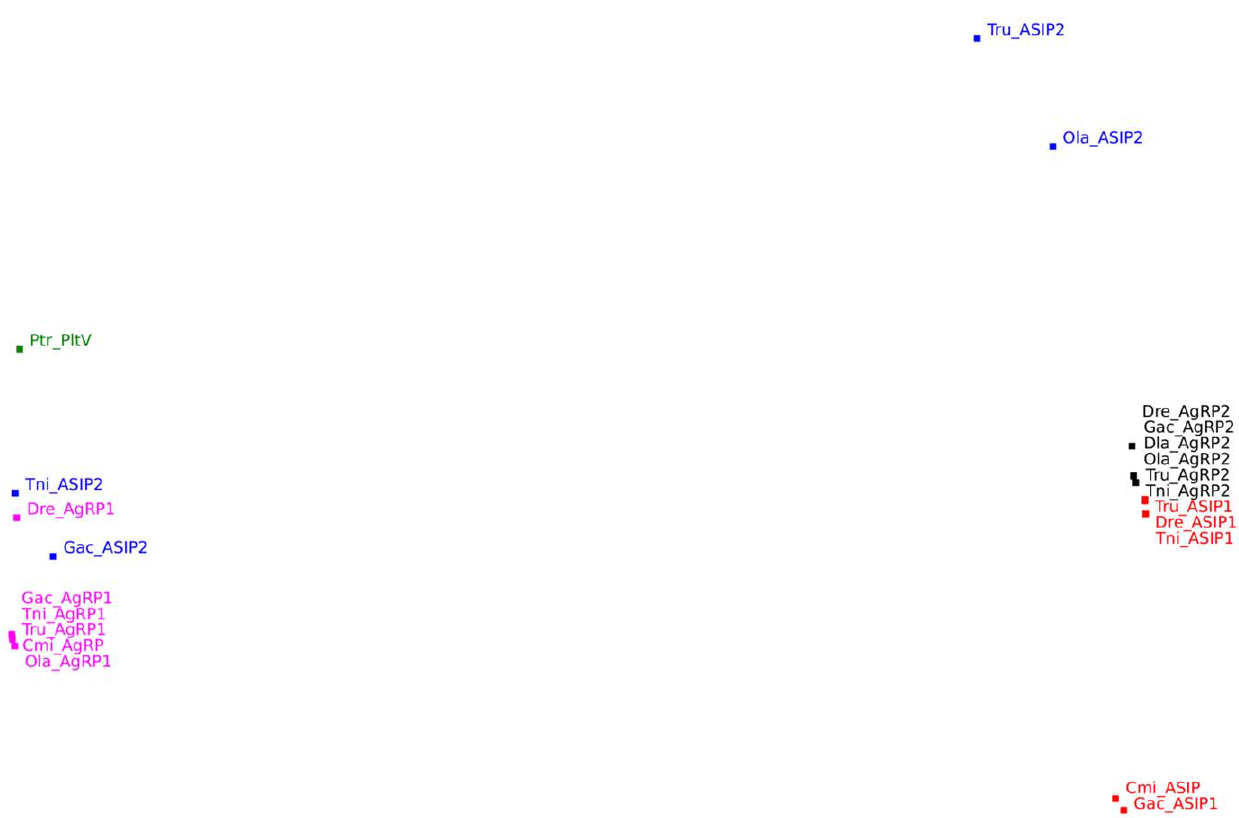
Figure 3. Two-dimensional representation of the similarity relationships between the structure models of A1 and A2 inhibitor cysteine knots, as obtained by non-metric multidimensional scaling. The MDS fit measures (s-stress =0.14, RSQ=0.95) indicate that the inter-model distances in this configuration reflect well the original inter-model dissimilarity values. The figure is generated by a Perl script that outputs support vector graphics. The figure shows that AgRP2 is more ASIP-like, and ASIP2 more AgRP-like, The shift of the A2 points towards ASIP agrees with the Mr. Bayes phylogram. Ptr Plt-VI is more AgRP-like.